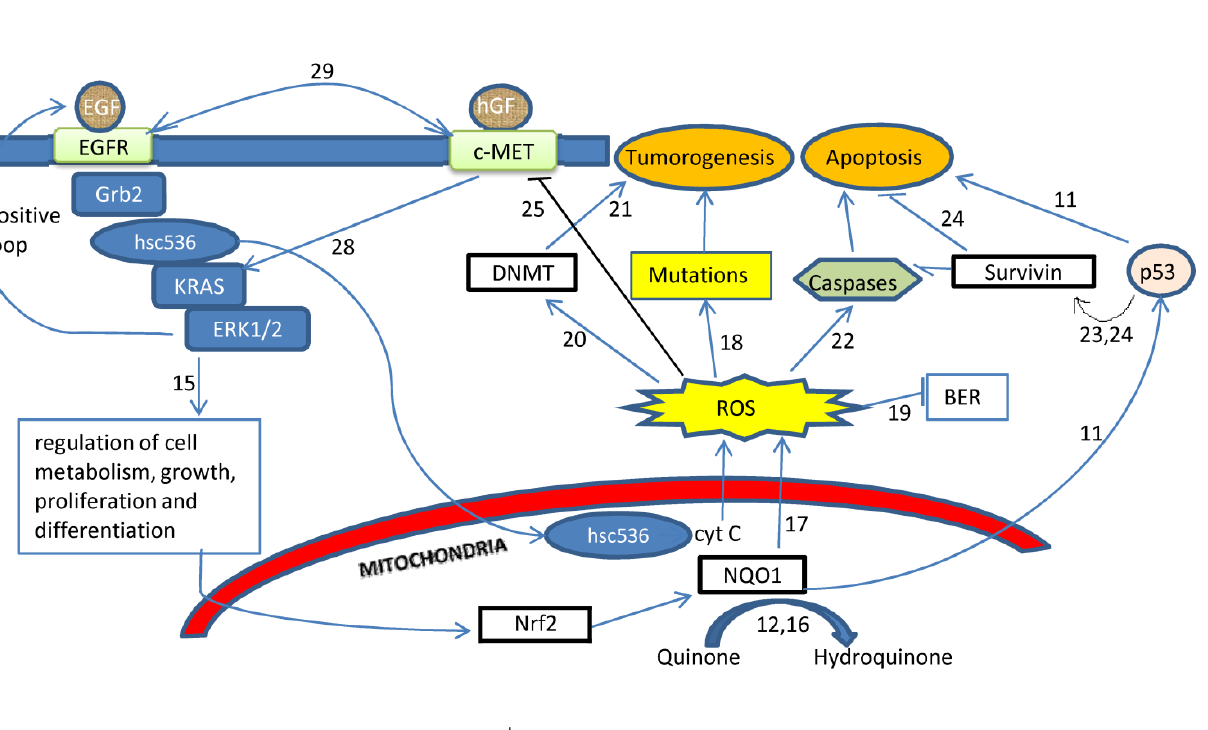
Figure 1. Inter-relationships among oxidative stress, KRAS , NQO1, survivin, DNA methyltransferases, and c-MET in the pathogenesis of lung cancer a,b